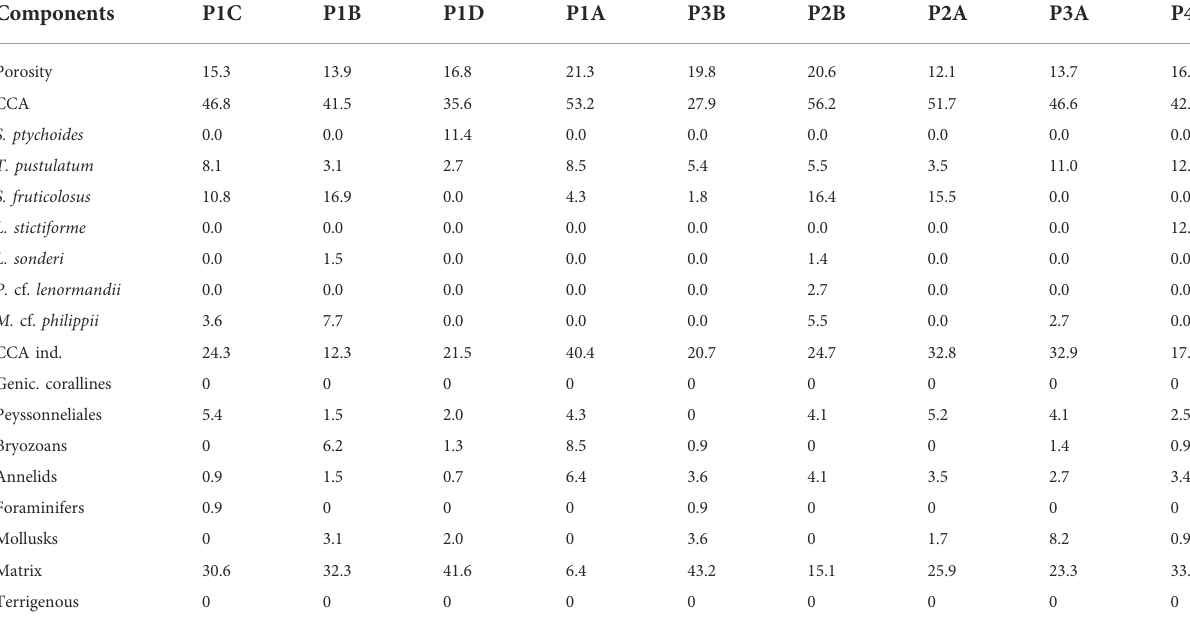
TABLE 3 Point counting results for the 9 thin sections of the Porto fi no